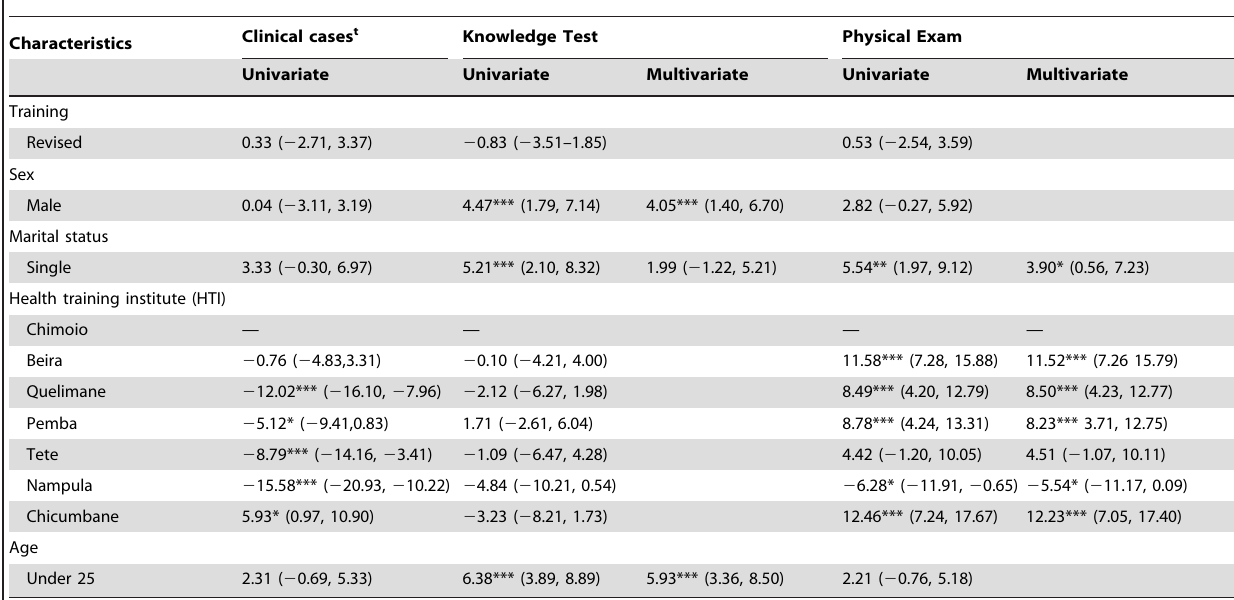
Table 4. Univariate and multivariate factors affecting scores by assessment type.